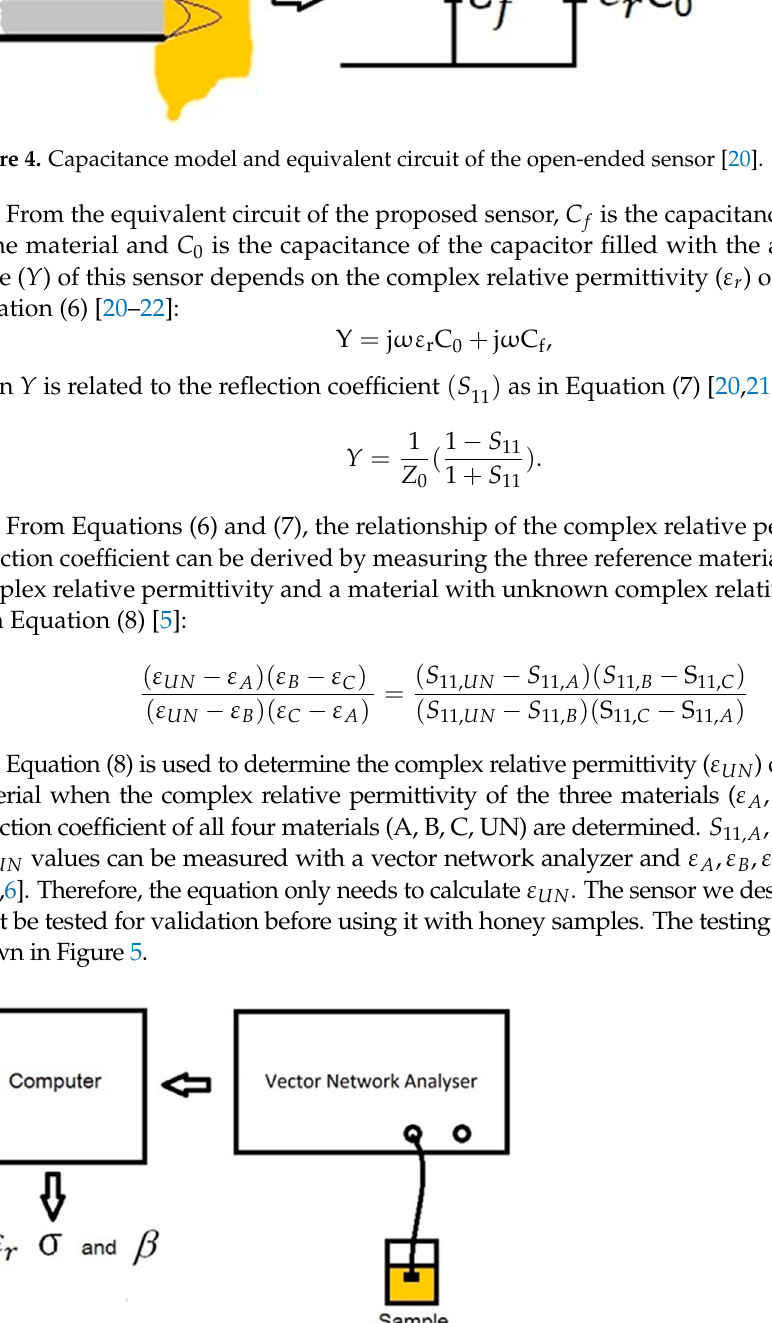
( b ) Figure 3. ( a ) The design of the modified SMA connector. ( b ) A photograph of the proposed sensor. In Figure 3a, A is the diameter of the inner coaxial core of 1.30 mm; B is the diameter of the outer coaxial core of 4.35 mm. The dielectric material in the connector is made of Teflon with 𝜀 (cid:3045) of 2.08. The impedance of this connector is 50 Ω that can be calculated by Equation (5) [20] as follows: